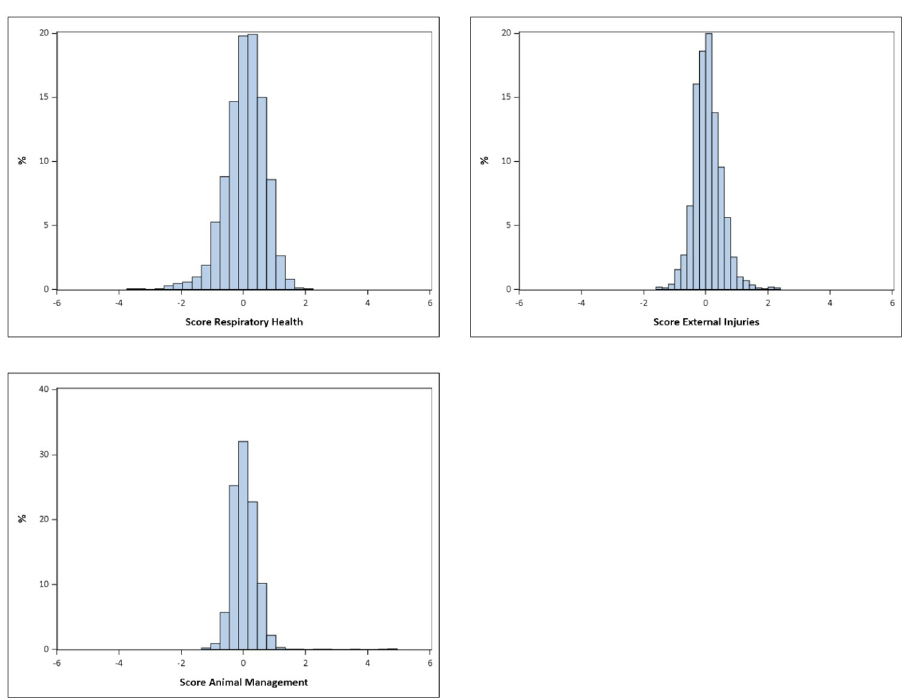
Fig 4. Distribution of score values for Respiratory Health, External Injuries/ Alterations and animal management.